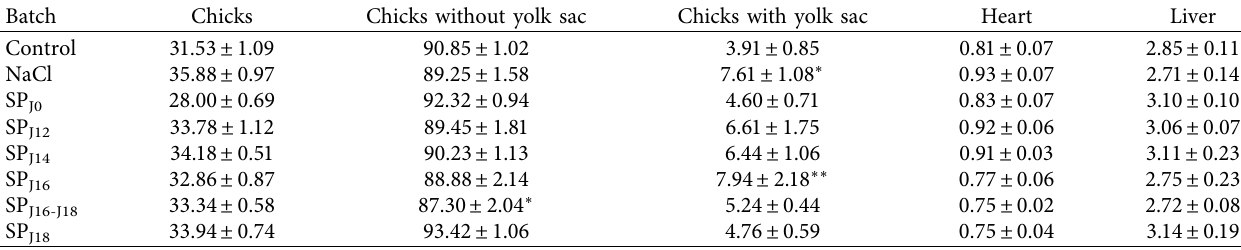
Table 1: Effect of sulfadoxine-pyrimethamine injection on relative weights (%) of chick and organ. Batch